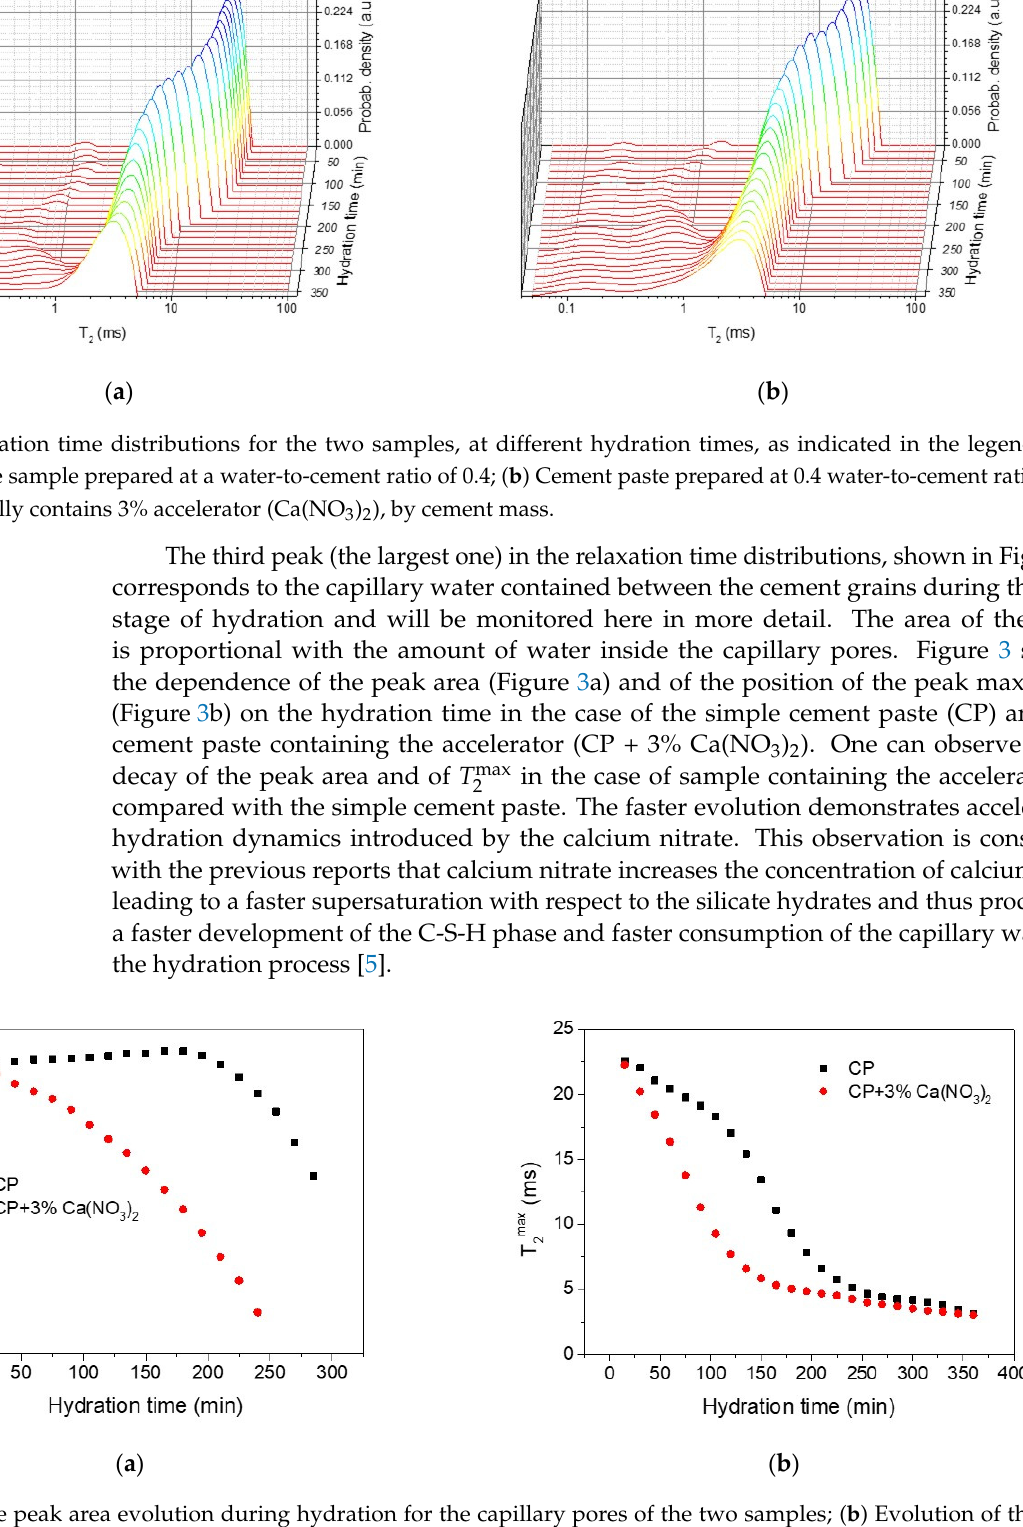
Figure 1. CPMG echo trains recorded for the two samples, at different hydration times, as indicated in the legend: ( a ) Cement paste sample prepared at a water-to-cement ratio of 0.4. ( b ) Cement paste prepared at 0.4 water-to-cement ratio which additionally contains 3% accelerator (Ca(NO 3 ) 2 ).